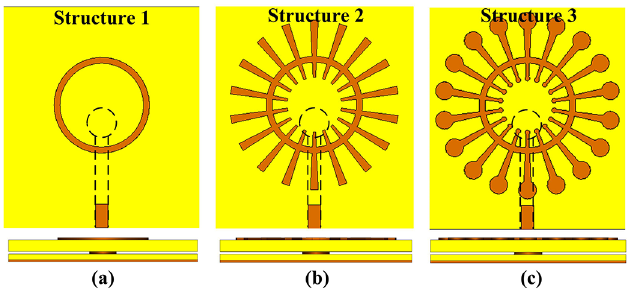
Fig. 2. The top view and side view of antennas based on (a) Structure 1, (b) Structure 2, and (c) Structure 3.